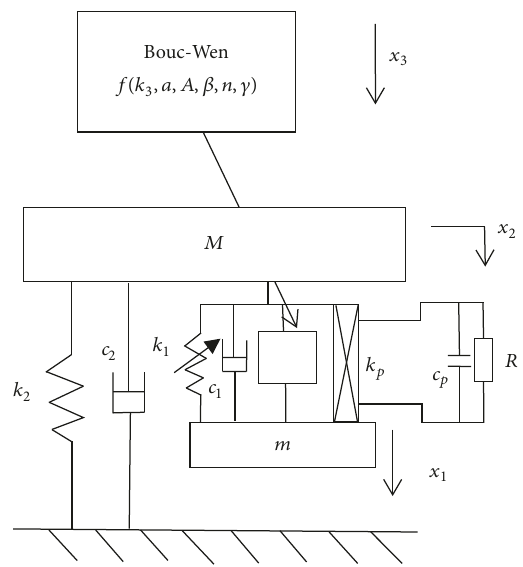
Figure 2: The single-degree-of-freedom system with NES-piezoe- lectricity system: configuration